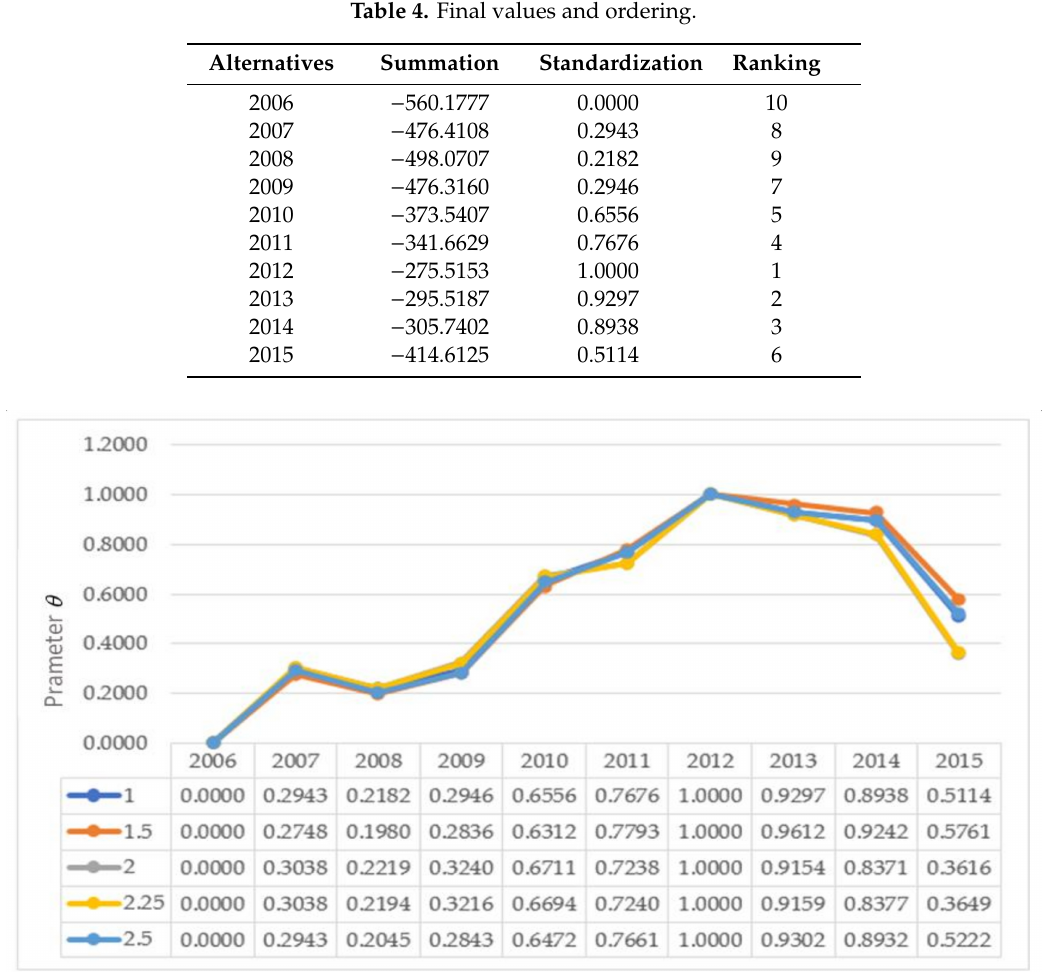
Figure 6. Impact of parameter θ on the decision